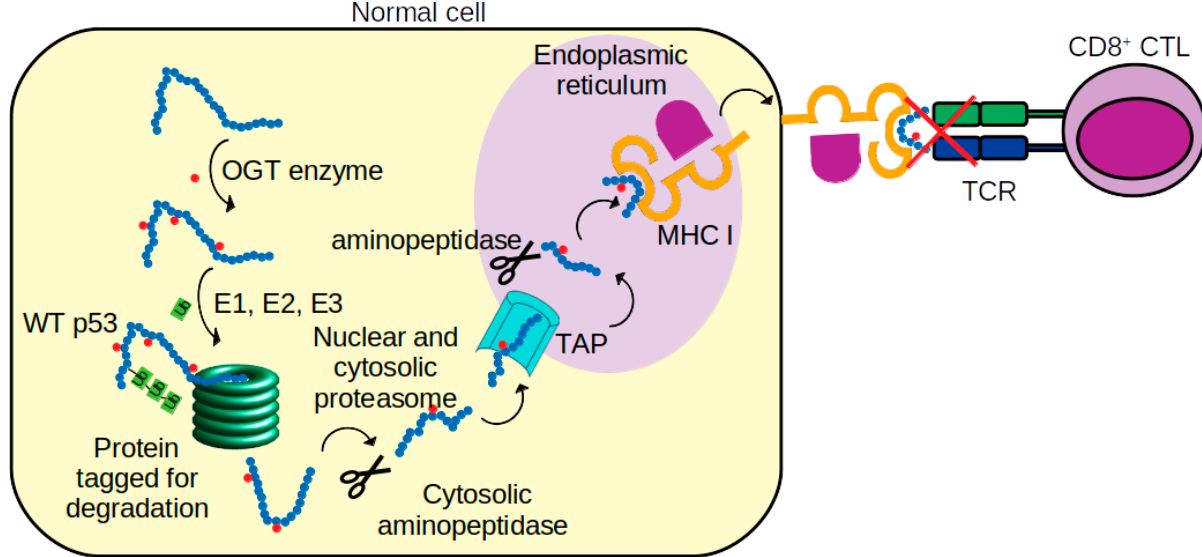
Figure 7. Schematic of p53 peptide presentations to cytotoxic T lymphocytes (CTL). p53 protein is first glycosylated (small red filled circles) by O-GlcNAc transferase (OGT) [64]. The glycosylated p53 is then tagged by ubiquitin (Ub chains) by ubiquitin-activating (E1), ubiquitin-conjugating (E2), and ubiquitin-protein ligase (E3) enzymes. Next, the protein is digested into peptides by proteasomes and aminopeptidase enzymes. The peptides are later translocated, via transporters associated with antigen processing (TAP), into the endoplasmic reticulum (ER). In the ER, the peptides are again trimmed by aminopeptidase and loaded on to nascent MHC class I molecules [65]. MHC class I-peptide complexes are then translocated to the surface of the tumor cell and recognized by the T cell receptor (TCR) of CD8 + CTL cell. Our simulations suggest that in some normal cells, the glycosylated p53 peptide in the complex with MHC I is not recognized by TCR.